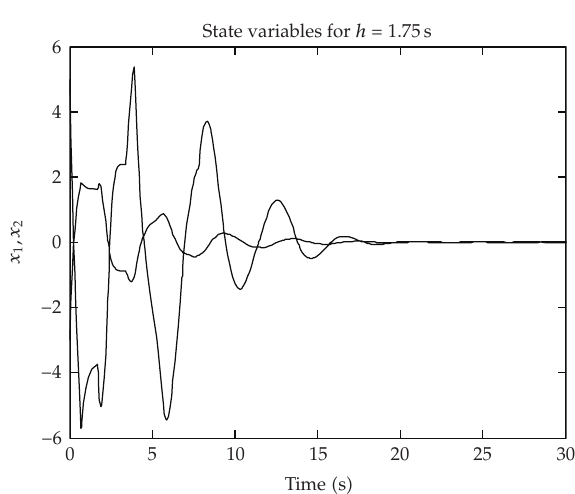
Figure 7: State trajectories evolution for a delay of 1.75